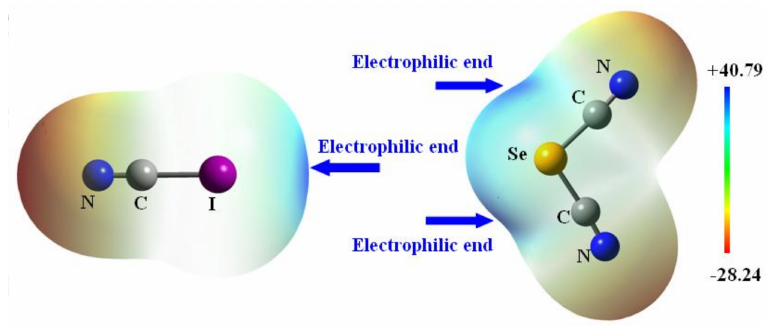
Figure 1. The electrostatic potentials on the 0.0004 au isodensity surfaces of NCI and (NC) 2 Se with a scale of − 28.24 to +40.79 kcal/mol.